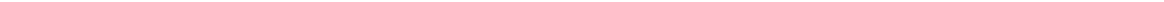
injection. a Myc-tagged ITSN1 -WT increased active Cdc42 levels upon overexpression in HEK293T cells as compared to mock, whereas three out of fi ve ITSN1 mutants from pTSNS patients failed to show any signi fi cant increase in active Cdc42 upon overexpression. b Active Cdc42 level was measured in COS7 cells. Myc-tagged ITSN2 -WT overexpression increased active Cdc42 levels as compared to Mock. However, all three ITSN2 mutants from pTSNS patients failed to show any signi fi cant increase in active Cdc42 upon overexpression. Error bars are de fi ned as the standard error of at least four